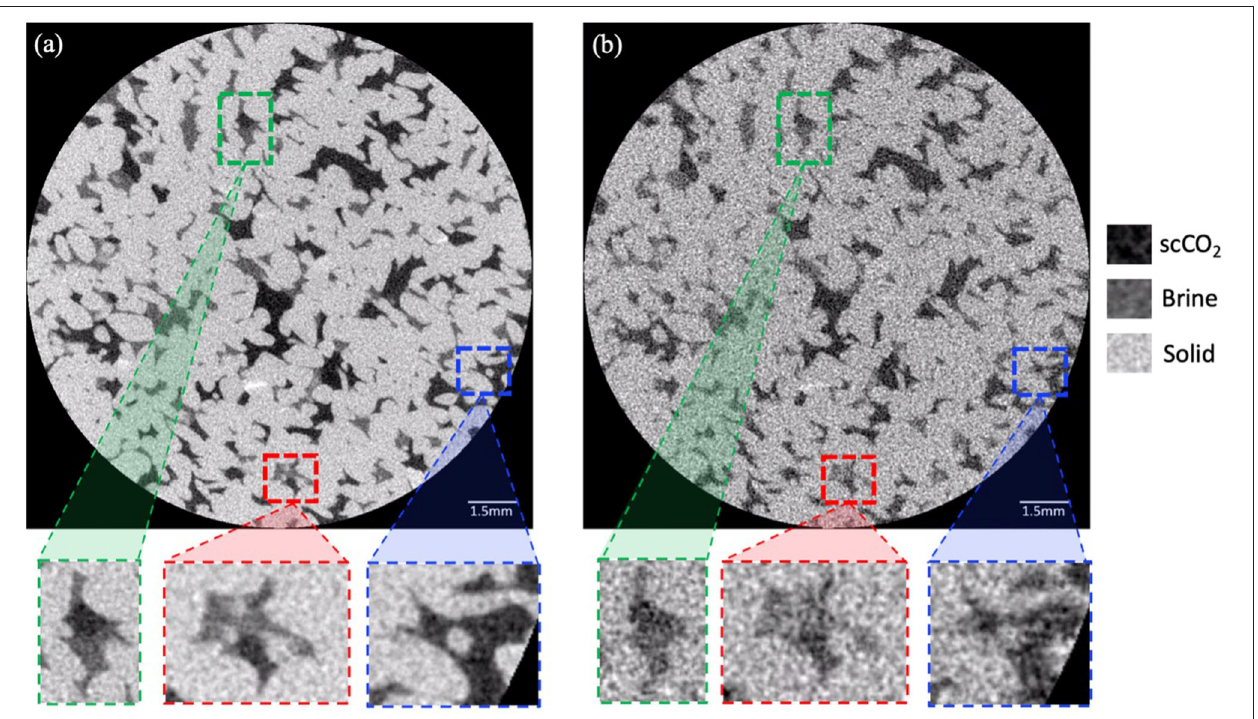
FIGURE 1 | (a) Sample cross-sectional slice from the HQ dataset, (b) Sample cross-sectional slice from the LQ dataset. Dashed boxes represent spatial features that demonstrate differences between the two datasets. The red box represents an example region which can cause deviation in calculated porosity. The blue box represents an example region which can cause deviation in calculated connectivity. The green box represents an example region which can cause deviation in calculated